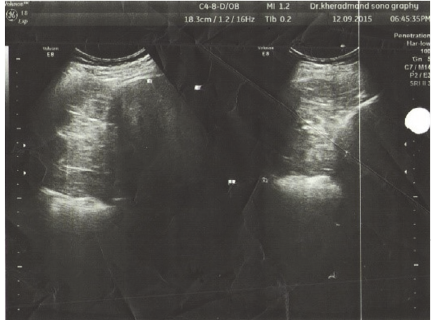
Figure 2: Sonography chest.